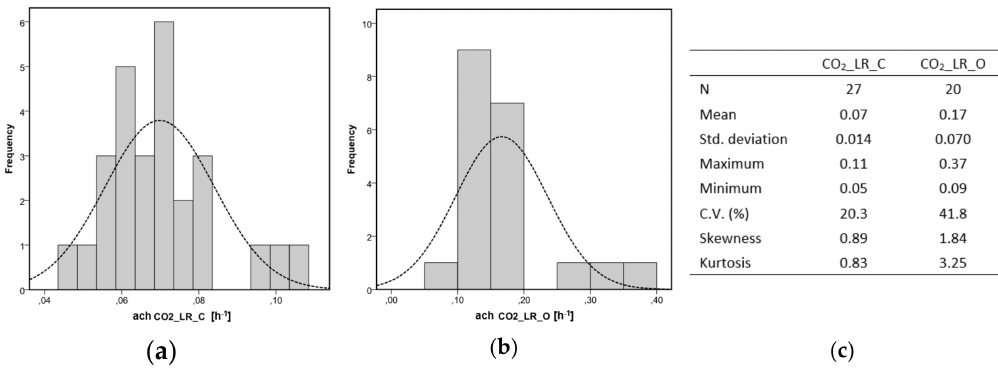
Figure 6. Carbon dioxide (CO 2 ) measurements of the air change rate in the living room (LR): ( a ) Histogram—door closed (CO 2 _LR_C); ( b ) Histogram—door open (CO 2 _LR_O); ( c ) Descriptive statistics indicators.